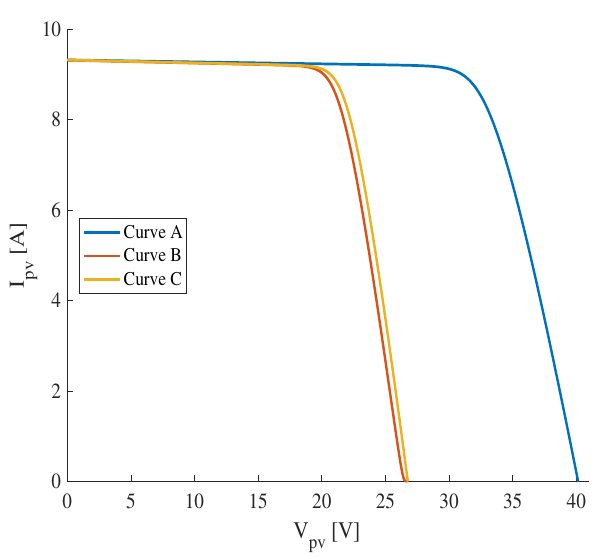
Figure 9. Curves A (blue line) and B (red line) obtained with simulation and curve C (yellow line) calculated with (5) and (6).